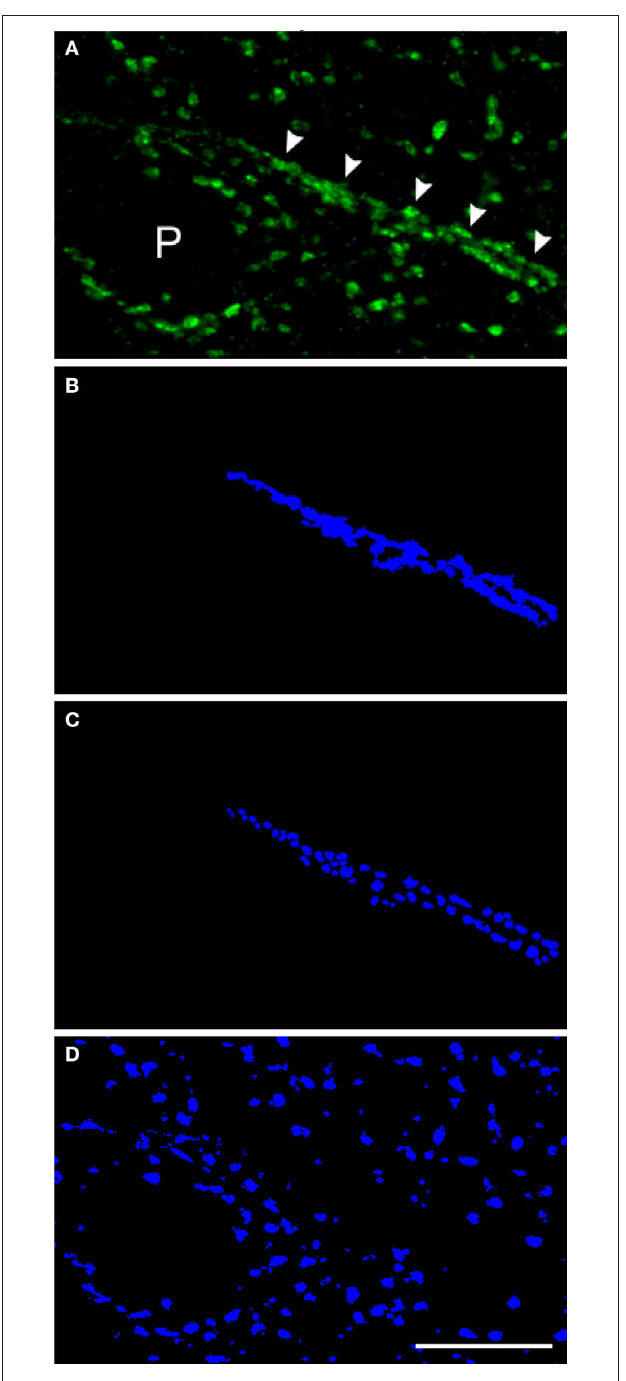
Figure 5 | Parvalbumin-positive inhibitory boutons. (A) Projection images of deconvolved confocal image stacks (13 z -planes taken 0.22 μm apart) labeled for PV in Cryostat sections (40 μm). Arrowheads indicate a chandelier cell cartridge. An unlabeled pyramidal cell (P) is surrounded by PV + presumptive basket cell boutons. (B,C) The entire PV cartridge was masked (B) followed by the masking of puncta that make up the cartridge using a modification of our iterative segmentation methodology (C) . (D) Shows the mask objects remaining after using our masking method followed by the subtraction of mask objects that colocalized with the mask in (B) . The objects thus represent the PV + boutons not located within cartridges. Bar = 10